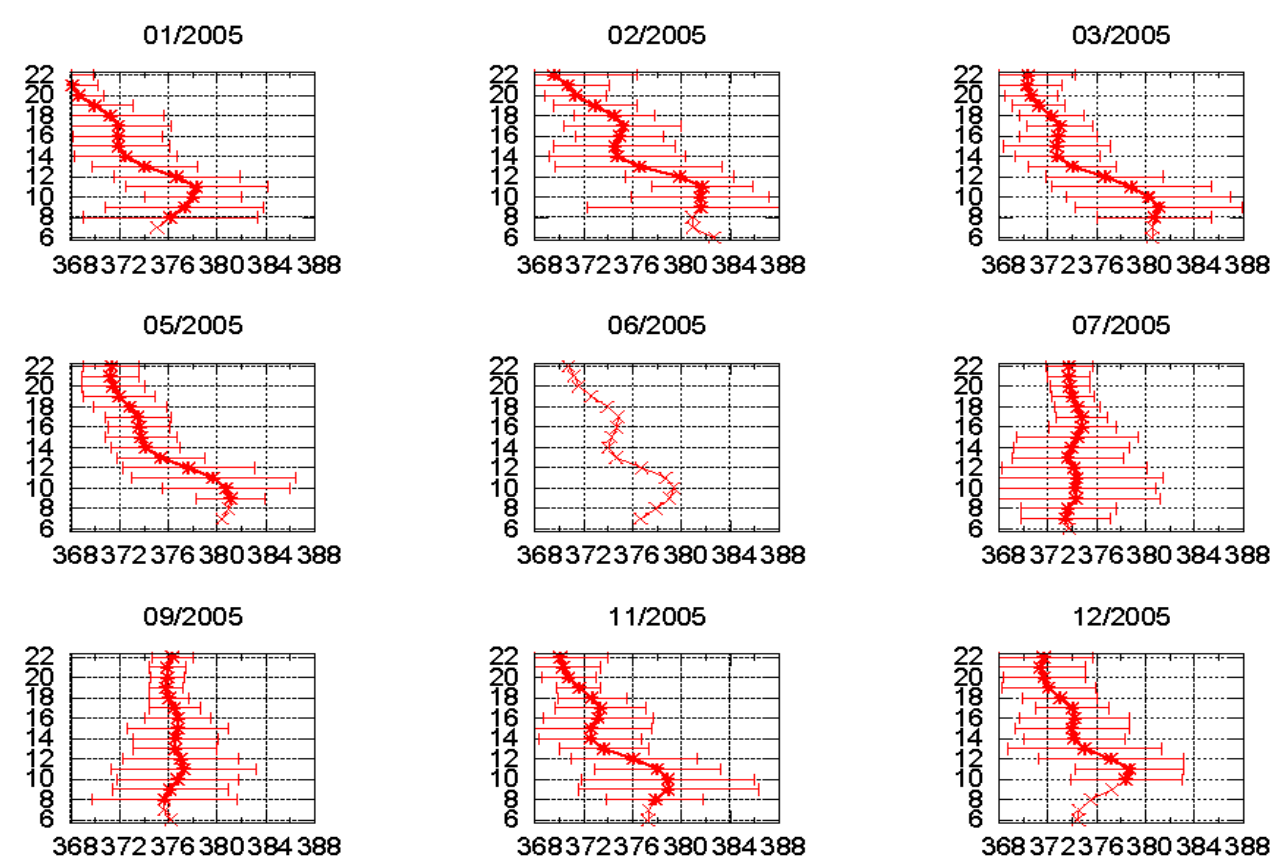
Fig. A1. Monthly mean CO 2 concentration (x-axis in ppm) evolution with altitude (y-axis in km) for nine months of 2005 for the 50 ◦ N– 60 ◦ N latitude band. Horizontal bars correspond to the standard deviation of retrieved CO 2 profiles for each altitude. ACE thin red line indicates that less than 10 occultations were available; in that case, standard deviation is not estimated.